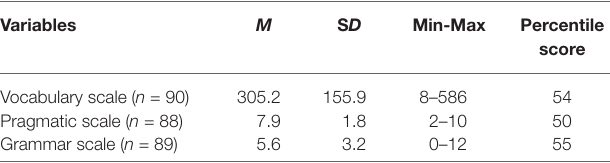
Vocabulary scale ( n = 90)